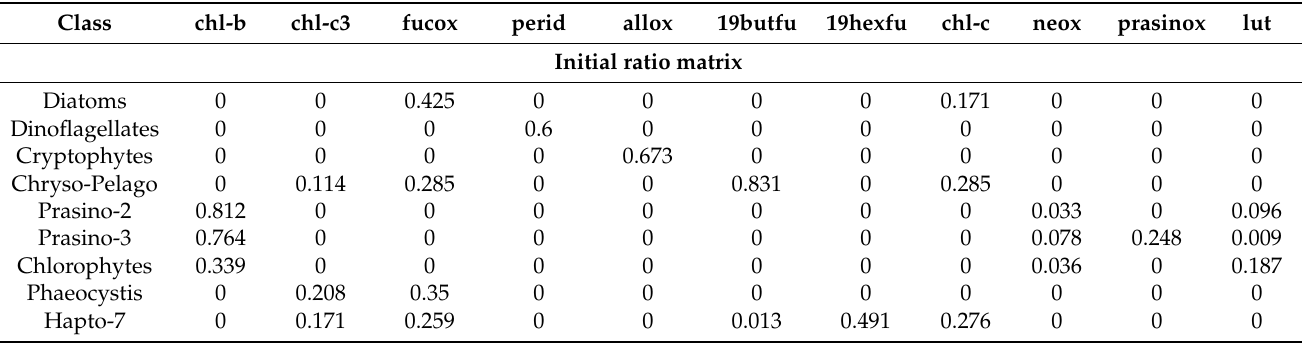
Table 2. Pigment:chlorophyll- a ratios for nine algal groups referred to [32]. CHEMTAX initial ratio matrix and final pigment ratios obtained by CHEMTAX on the pigment